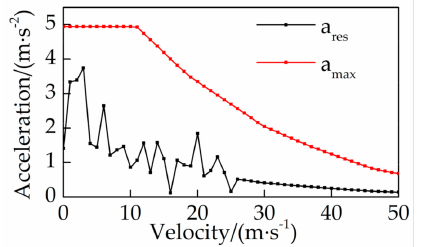
Figure 19. Acceleration reserves under the FTP cycle.